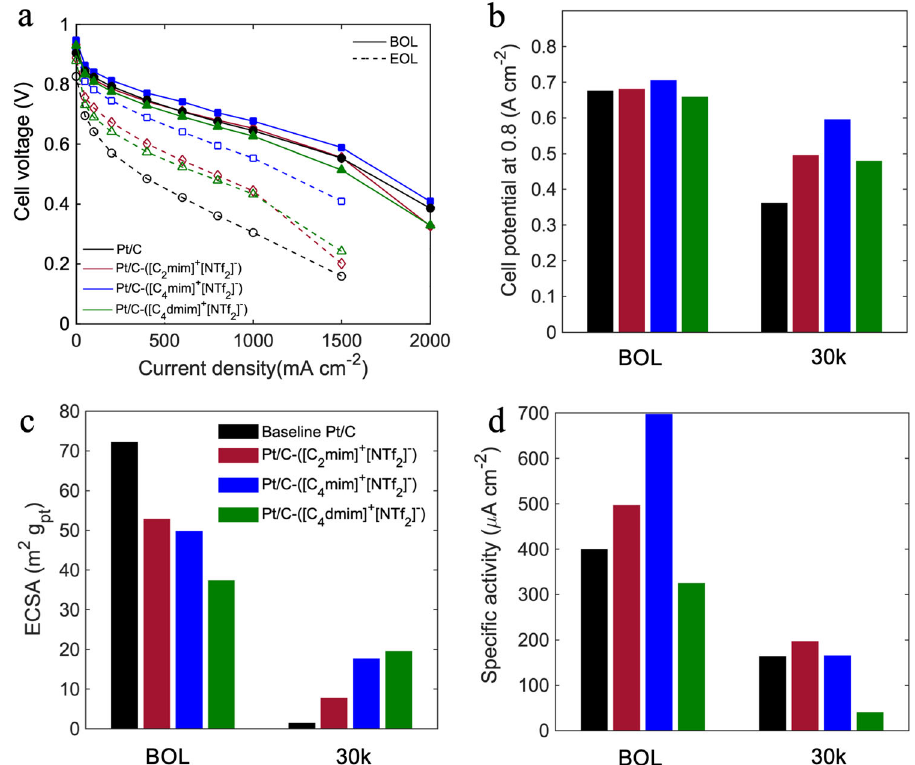
Fig.6|Comparisonofelectrochemicalpropertiesatthebeginningoflife(BOL) andafter30,000cycles(EOL)forPt/Cbaselinevs.Pt/C-([C 2 mim] + [NTf 2 ] − ),Pt/C- ([C 4 mim] + [NTf 2 ] − ), and Pt/C-([C 4 dmim] + [NTf 2 ] − ) MEAs. a Comparison of H 2 /air polarizationcurves, b cellpotentialat0.8Acm − 2 , c massactivitiesobtainedat0.9V